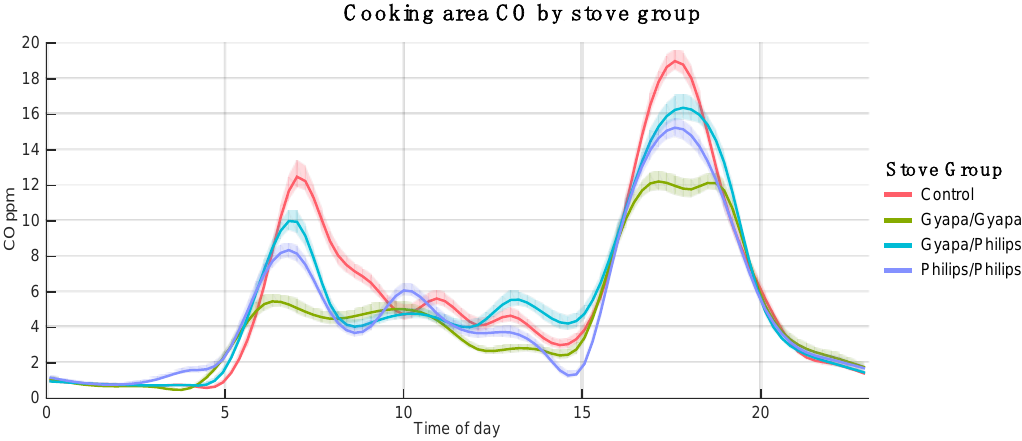
Figure 3. Spline-smoothed cooking area CO concentration by hour of day (0 = midnight) and stove group.